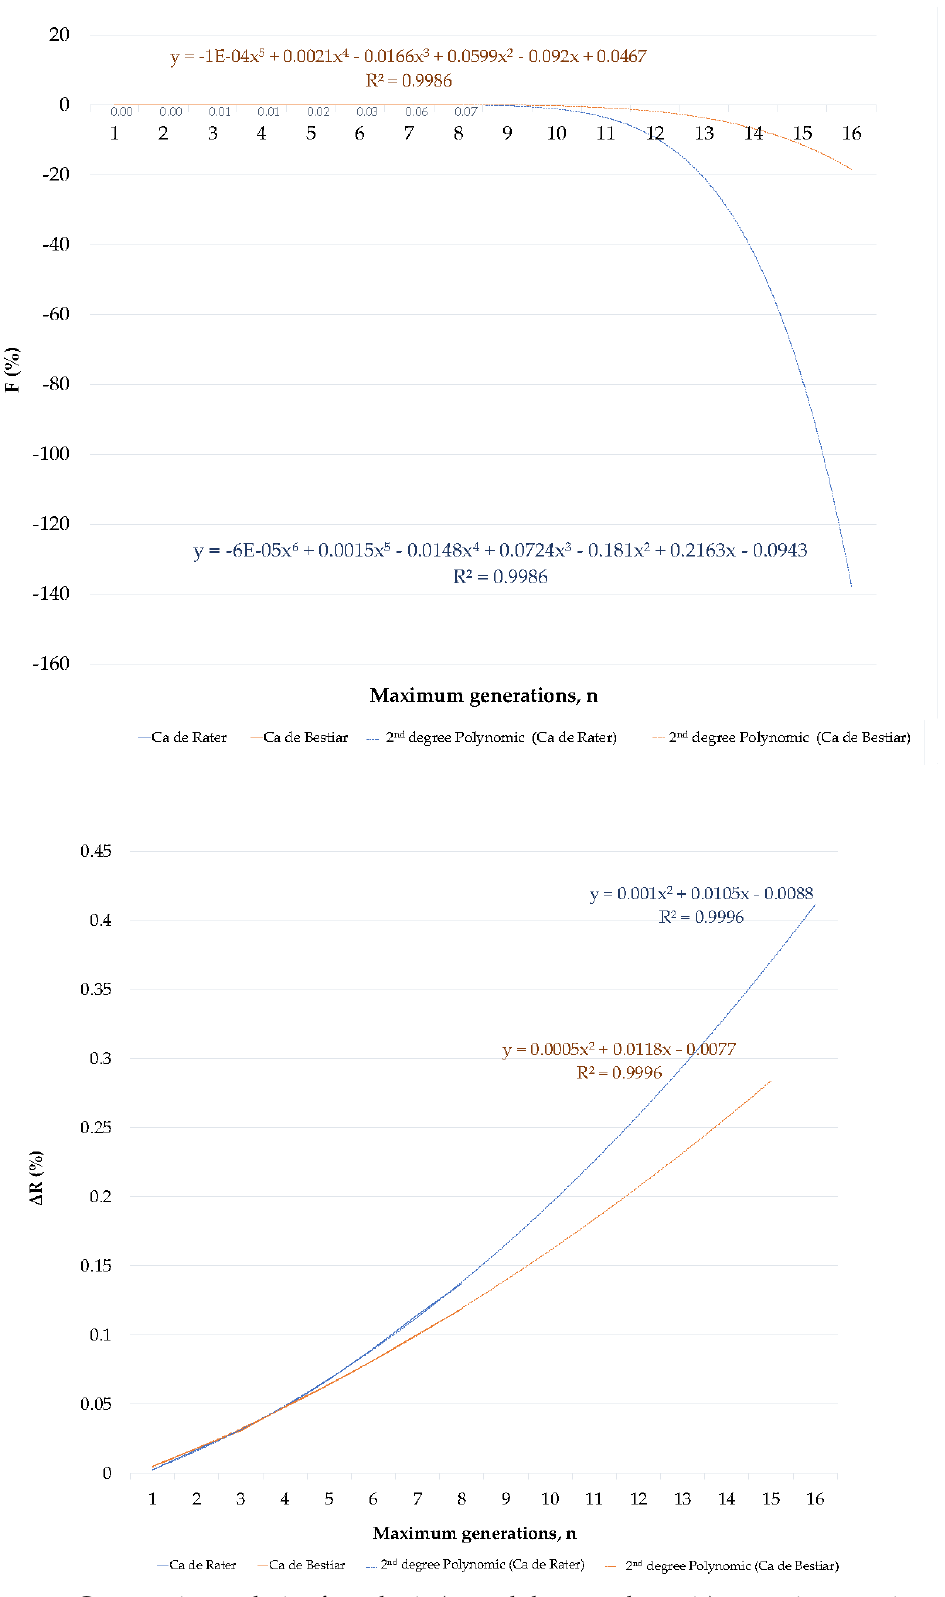
Figure 2. Comparative analysis of quadratic (second-degree polynomic) regression equations for mean inbreeding (F) and relatedness coefficients (ΔR) from the first to fifth generation and predicted inbreeding (F) and relatedness coefficients (ΔR) from the sixth to 15th generation in the Ca de Rater and Ca de Bestiar dog breeds.